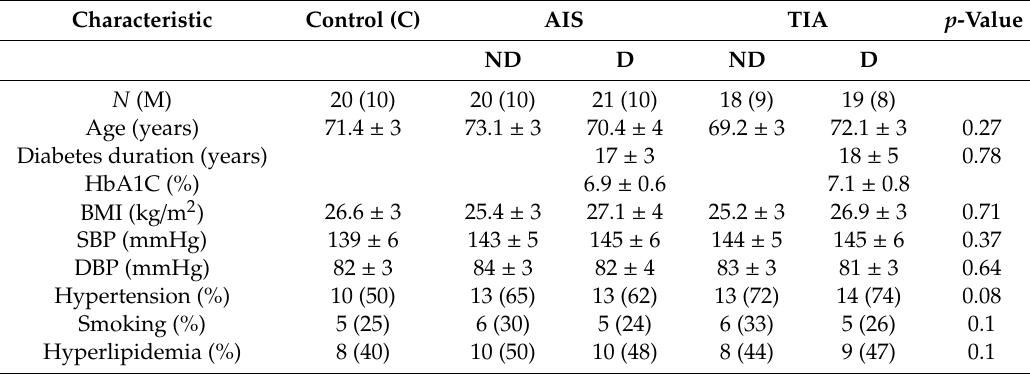
Table 1. Clinical characteristics in the control subjects (C) and in the diabetic (D) and non-diabetic (ND) patients with acute ischemic stroke (AIS) and transient ischemic attack (TIA). N , number of patients; M, number of male patients; HbA1C, glycated hemoglobin; BMI, body mass index; SBP, systolic blood pressure; DBP, diastolic blood pressure. The values are indicated as mean ± standard error of the mean